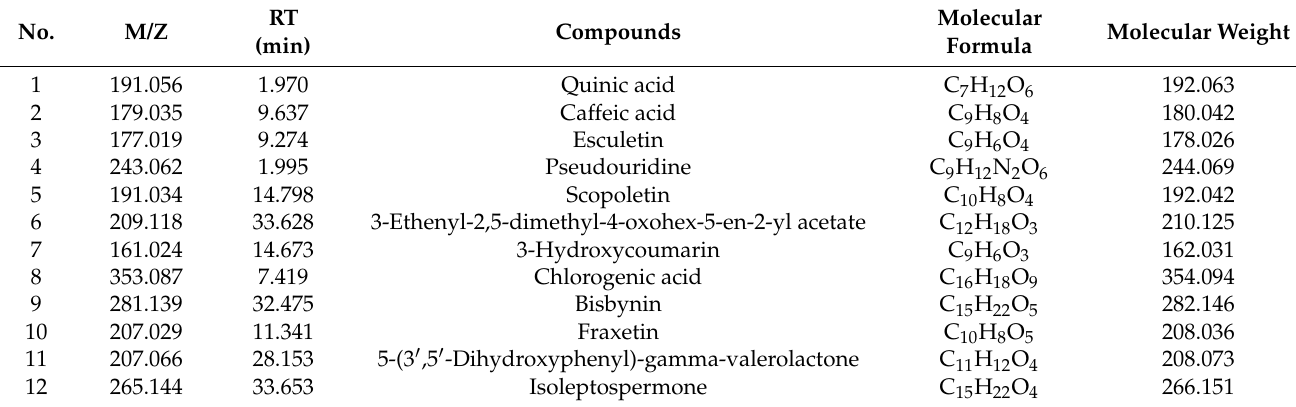
Table 3. Compounds identified in the ethanolic A. lancea extract by